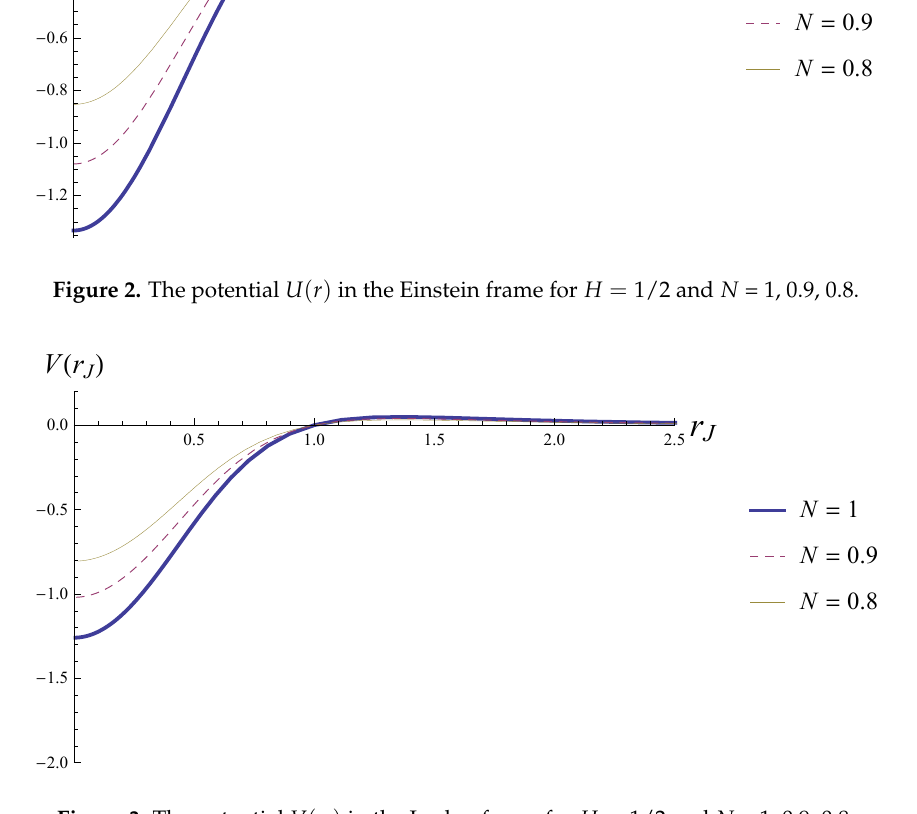
Figure 3. The potential V ( r